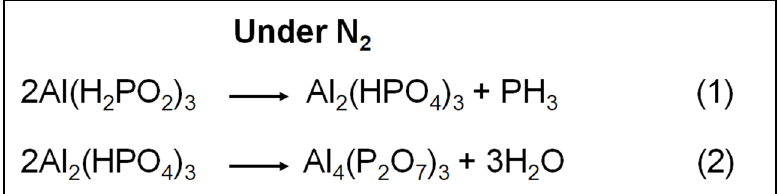
Scheme 1. Proposed mechanism of thermal decomposition of AHP under nitrogen.